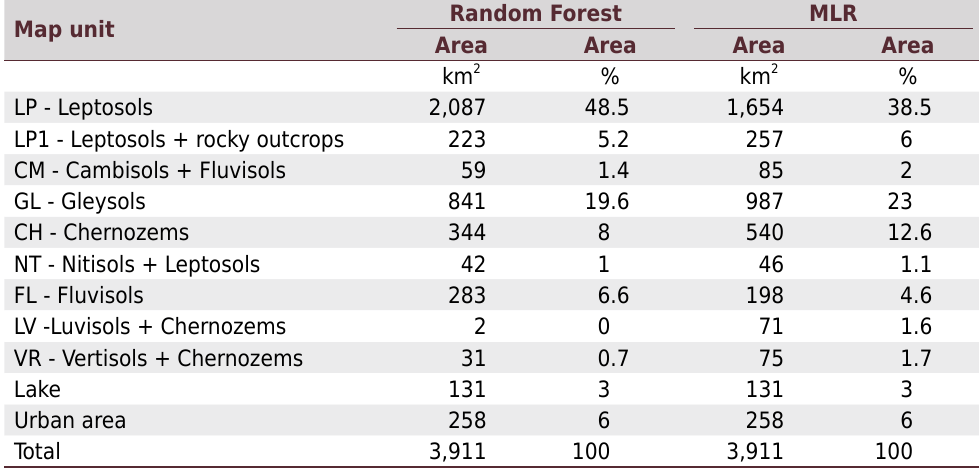
Table 7. Area of soil classes mapped by Random Forest and Multinomial Logistic Regression (MLR) Map